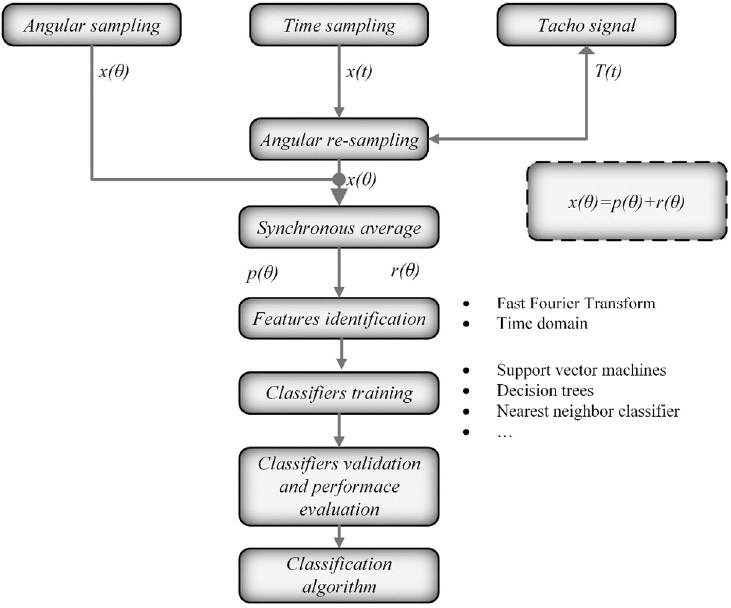
Figure 1. Flow chart of the suggested methodology for analyzing the acceleration signals.